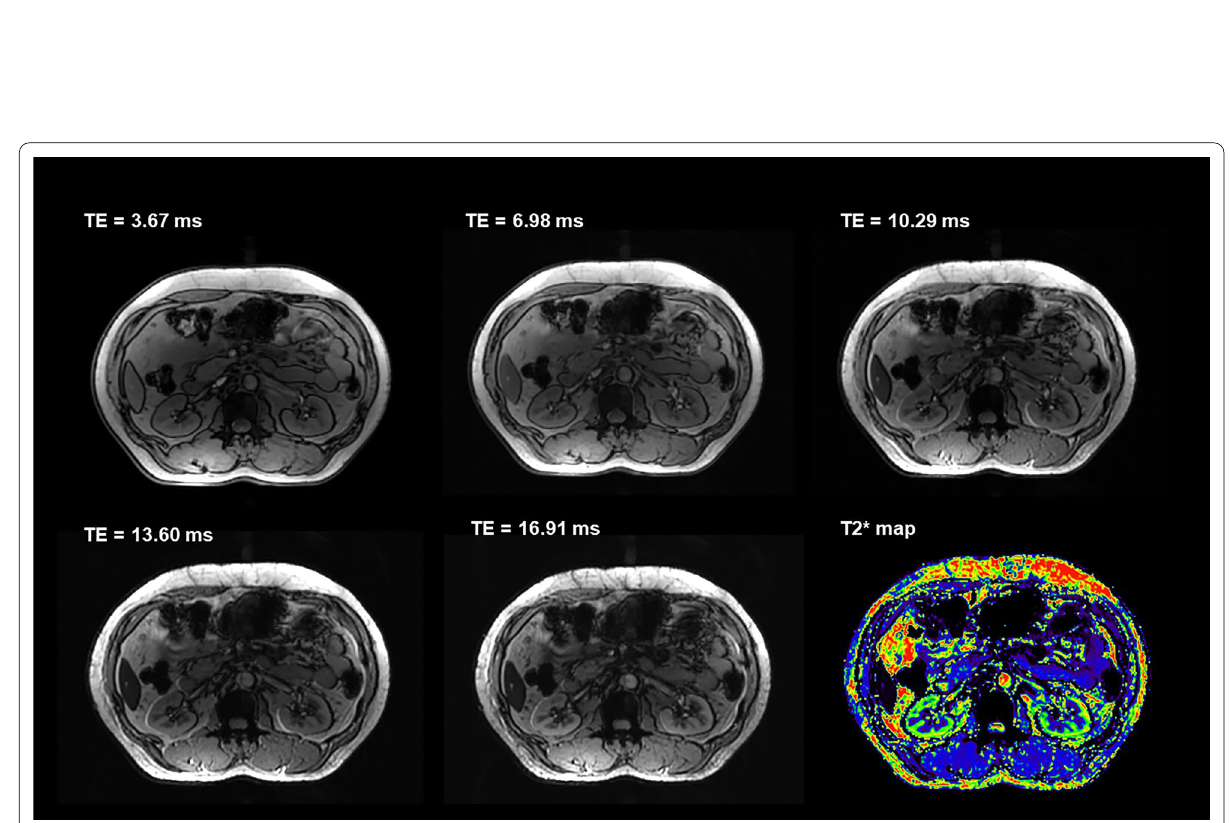
Fig. 4 Axial, multi-echo gradient-echo T2* mapping at 5 T from a 56-year-old